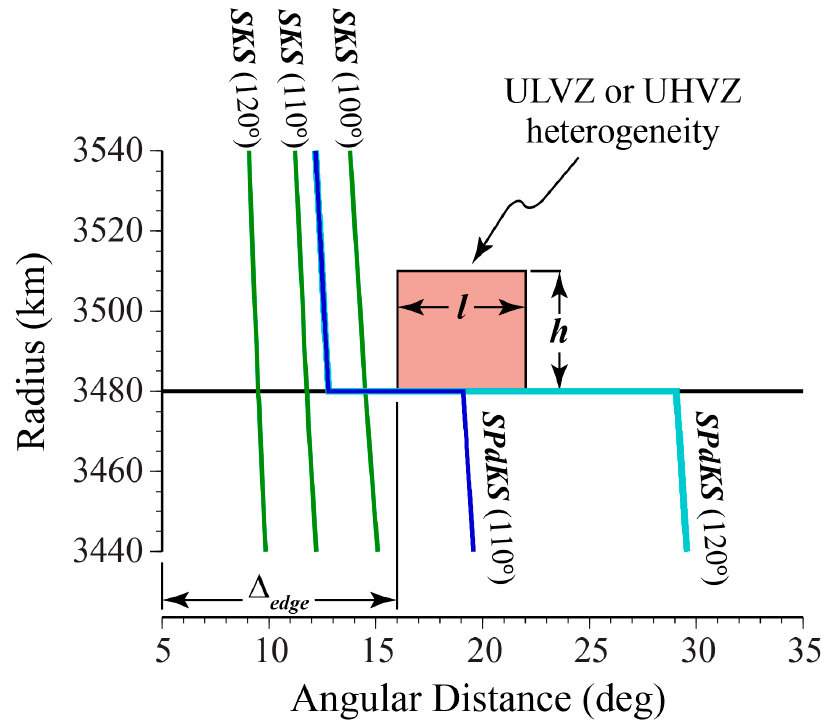
Figure 5. Schematic drawing of box-car ULVZ or UHVZ heterogeneity. The heterogeneity is drawn as the red box with height ( h ) and length ( l ) in the great circle arc direction. The left-most edge of the heterogeneity is located at an angular distance of ∆ edge away from the line connecting the source to the center of the Earth. Ray paths for the SKS arrival are drawn for epicentral distances of 100 ◦ , 110 ◦ , and 120 ◦ in green. Ray paths for the SPdKS arrival are drawn for epicentral distances of 110 ◦ (purple) and 120 ◦ (cyan).